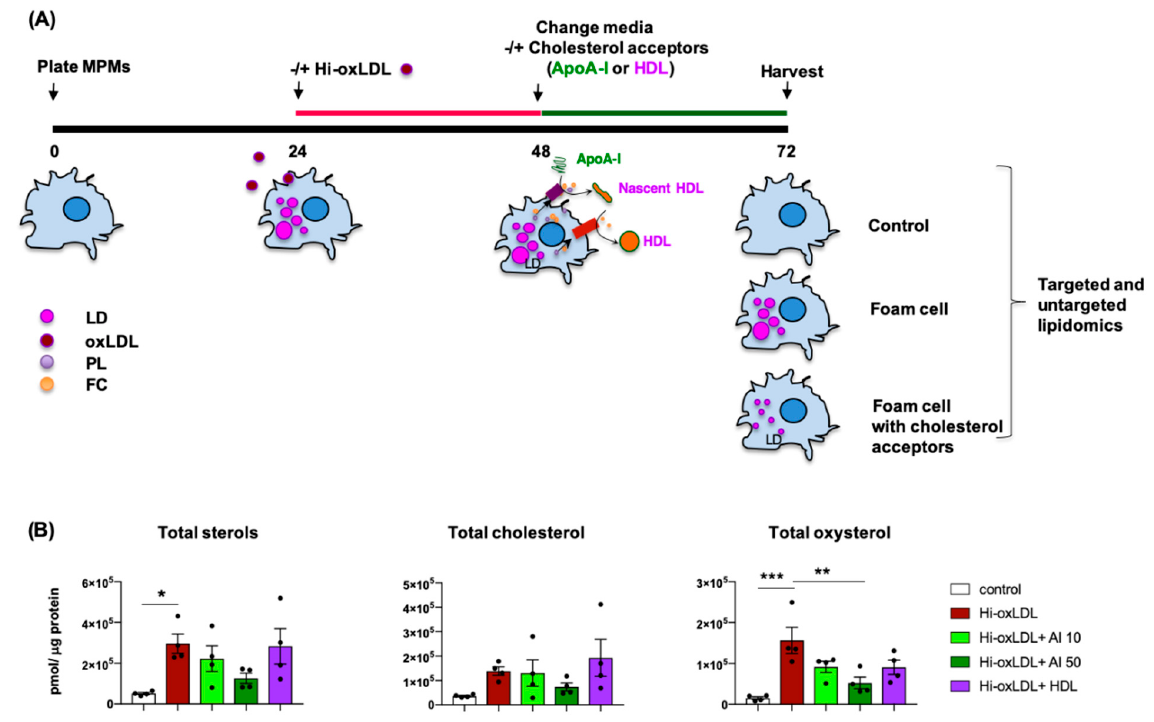
Figure 3. ApoA-I significantly reduces total sterols, cholesterol, and oxysterols in foam cells. ( A ) Experimental procedure. MPMs were loaded with hi-oxLDL (50 µ g / mL) for 24 h. The media was refreshed without hi-oxLDL followed by incubation with or without apoA-I (10 µ g / mL and 50 µ g / mL) or HDL (50 µ g / mL) for 24 h. Lipids were extracted, and sterol species were identified by MS. ( B ) The levels of total sterols, cholesterol, and oxysterols were presented as abundance obtained as pmol of lipids normalized with µ g of protein. The data were presented as mean ± SEM ( n = 4 per group). * p < 0.05, ** p < 0.005. *** p < 0.0005.